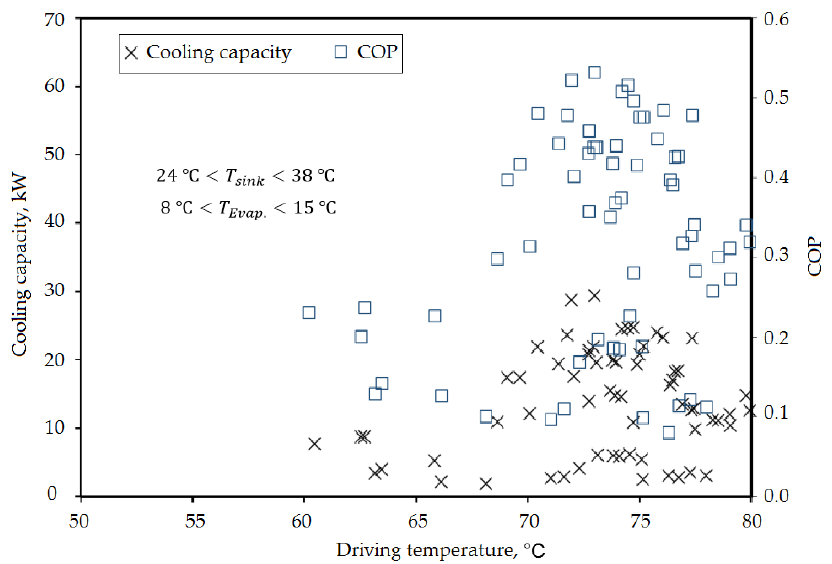
Figure 7. Cooling capacity and thermal Coefficient of Performance (COP) of the absorption chiller in GJU as a function of driving temperature, modified from [29].